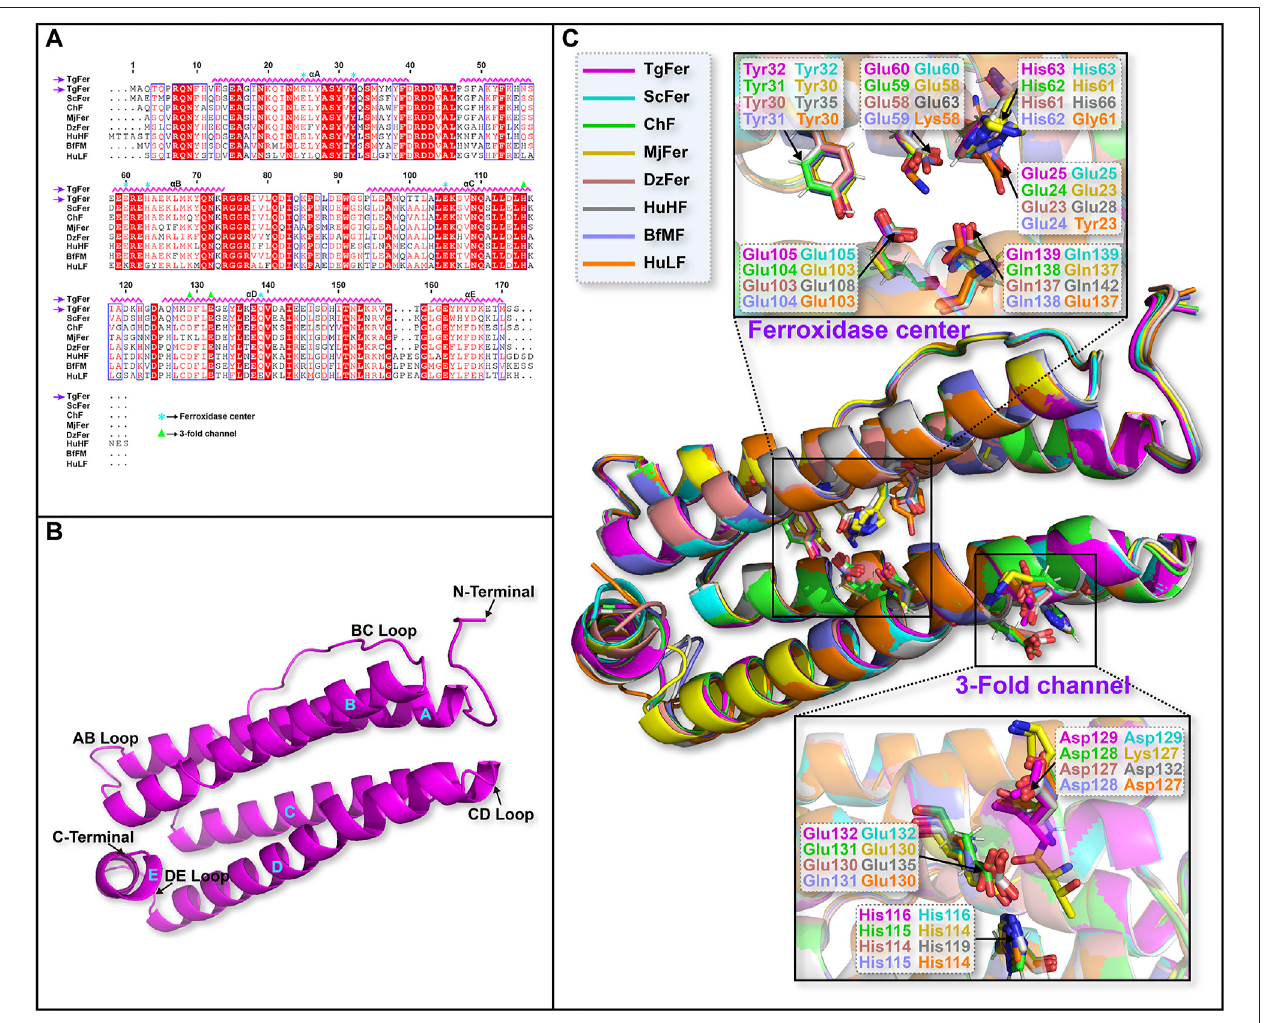
FIGURE 2 | (A) Multiple sequence alignment of TgFer compared with ferritins from other species. (B) Cartoon representation of the TgFer subunit. (C) Structure superposition of TgFer and the other seven